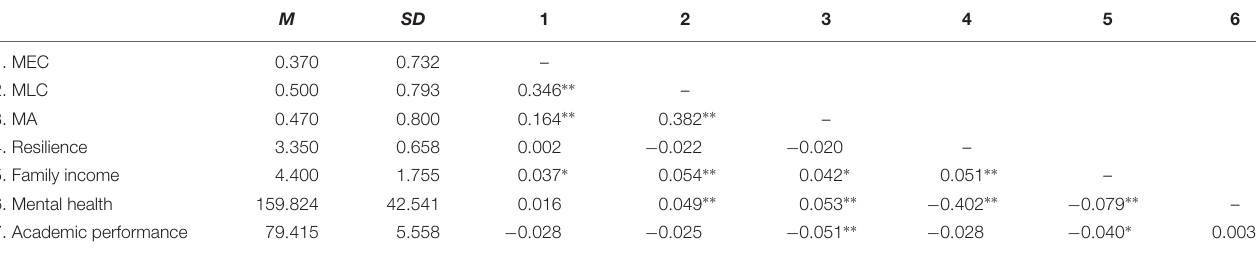
TABLE 1 | The descriptive statistics of key variables and their inter-correlations. M SD 1 2 3